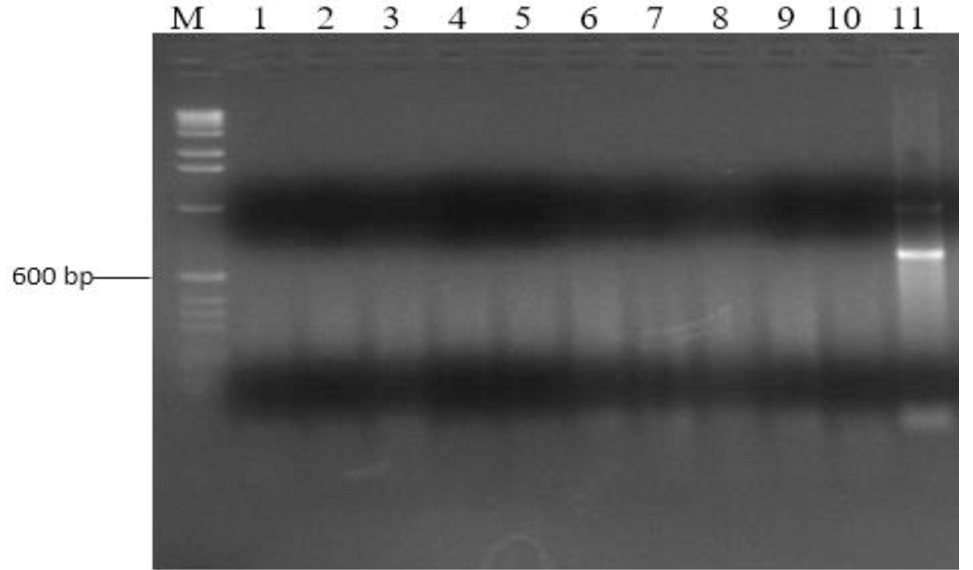
Fig 3. Agarose gel showing PCR amplicons from selected APEC isolates for serogroup O78. Lane M: DNA marker (100bp DNA ladder, ThermoFisher Scientific); Lanes 1–10: APEC isolates; Lane 11: APEC strain BEN2268 (O78 positive